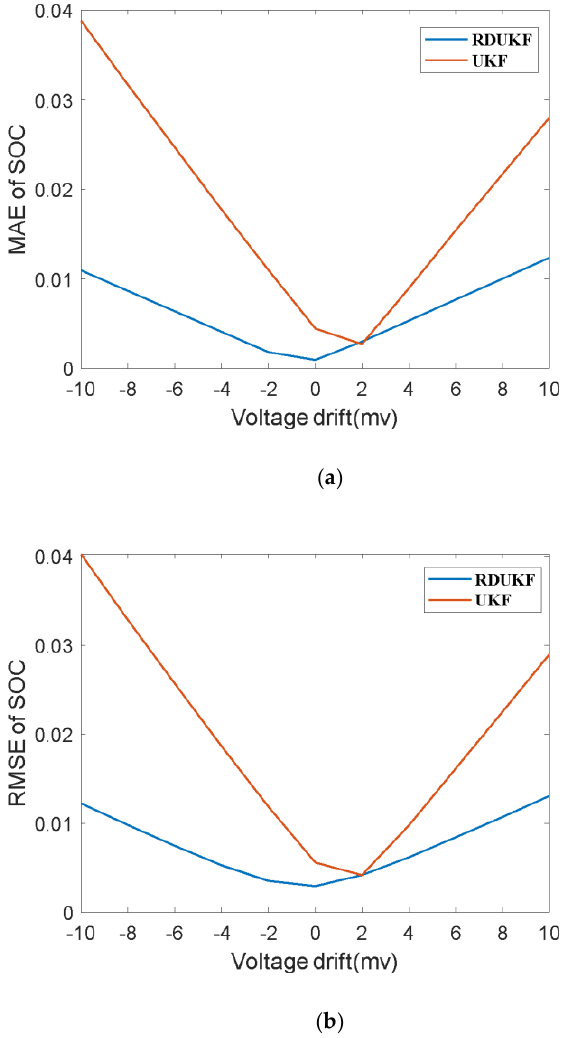
Figure 5. ( a ) MAE under different drift voltages; ( b ) RMSE under different drift voltages.